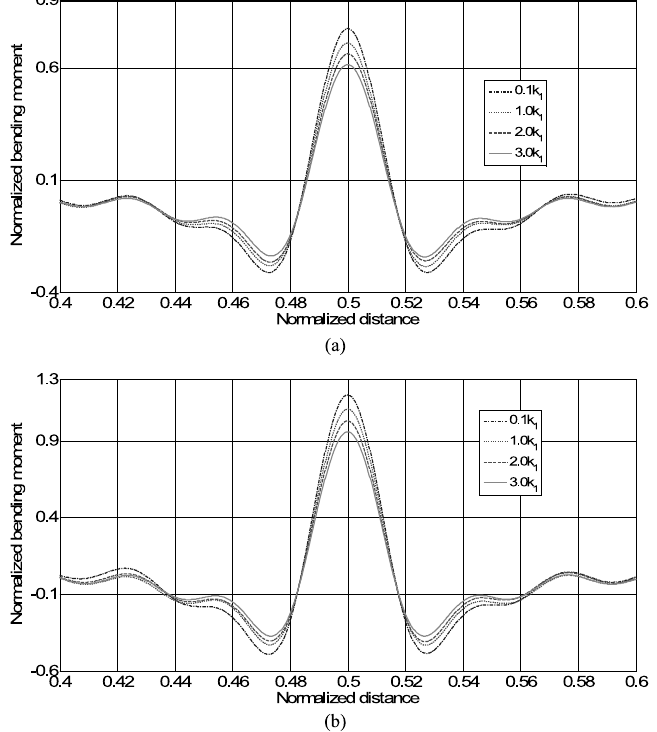
Fig. 10. Effect of shear modulus on dynamic bending moment responses at a constant speed of 88.25 km/h; (a) moving load (b) moving